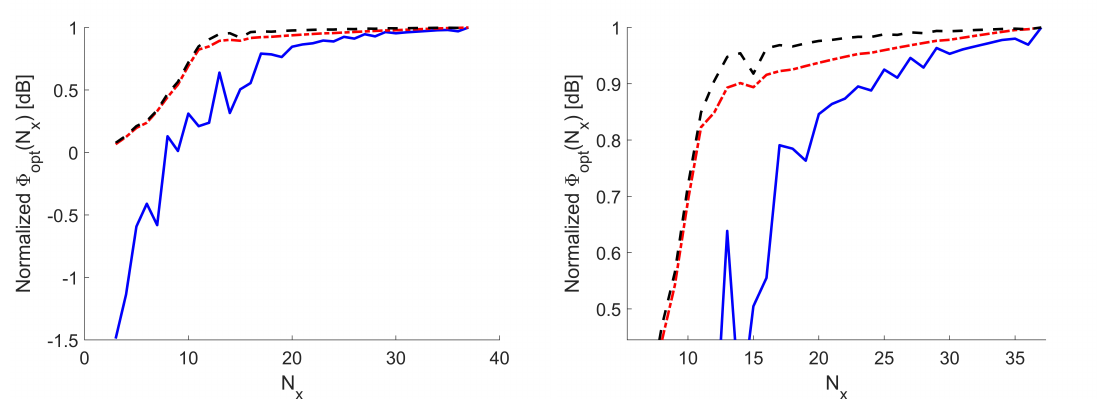
( i ) ( N x ) curves. The Φ ( 1 ) ( N x ) curve is reported in a log scale—all the curves are normalized to their Figure 9. Case B. Φ opt opt respective maxima. Blue solid line: Shannon number. Black dashed line: Mutual information. Red dash-dotted line: Fisher information. ( Left ) full curves. ( Right ) zoom around the knees.